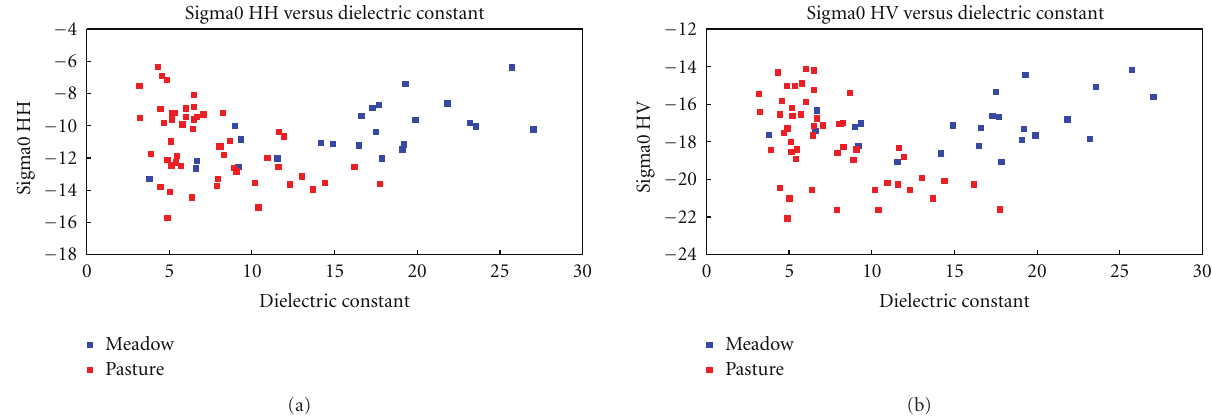
Figure 3: Scatter plots of backscattering coe ffi cients extracted from the RADARSAT2 images versus dielectric constant measurements in the case of (a) HH polarization configuration and (b) HV polarization